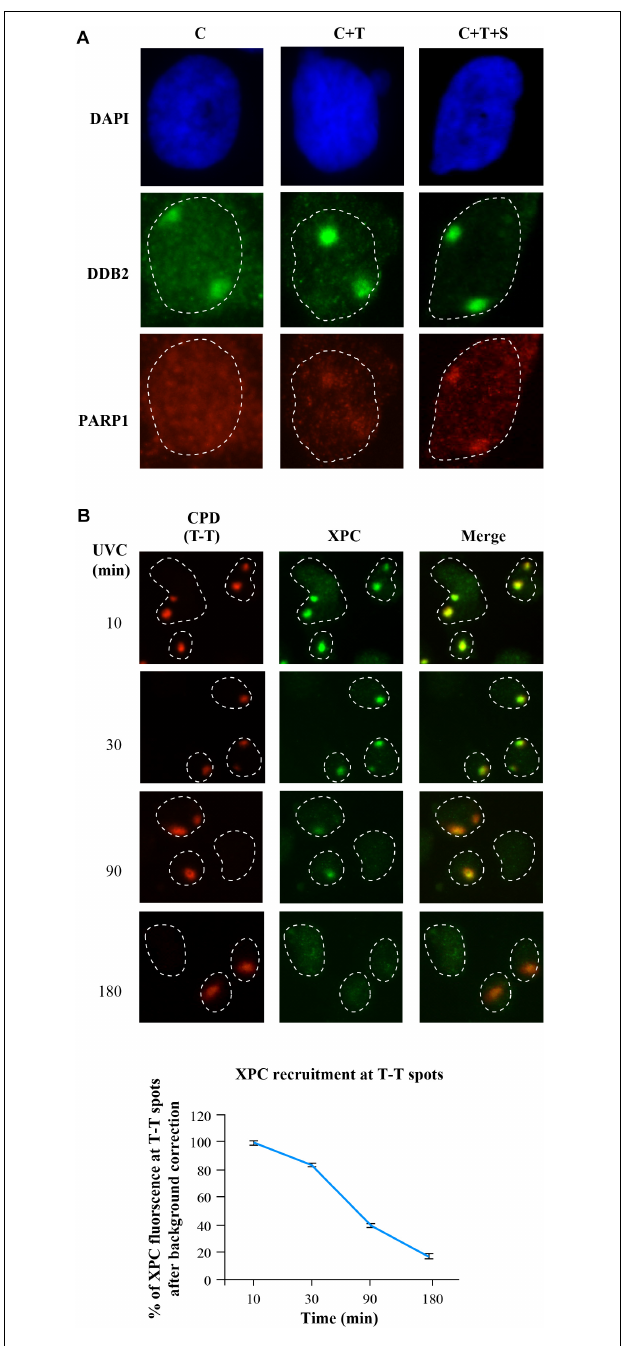
FIGURE 4 | In situ extraction for enhancement of signal for NER proteins DDB2, PARP1 and XPC at DNA damage site after local UVC irradiation. (A) GMU6 cells were irradiated locally with 100 J/m 2 UVC and after 10 min subjected to the three protocols (C, C+T, and C+T+S). The immunofluorescent visualization of DDB2 and PARP1 in DAPI stained nuclei improved significantly after each step of in situ extraction protocol. (B) The kinetics of XPC accumulation at CPD site after local irradiation was measured at the indicated time after C+T extraction protocol. Data from a least 100 T-T spots from 3 independent experiments were pooled and expressed as percent of the XPC signal at 10 min (100%). DAPI staining was carried out to define the